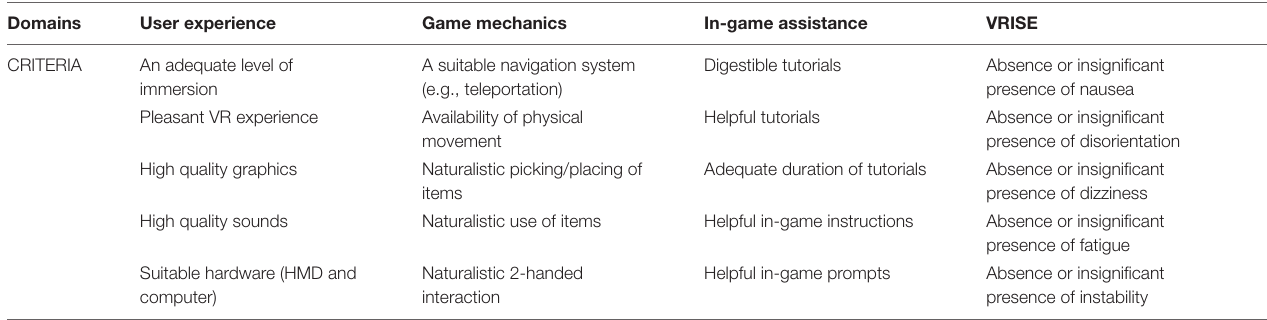
TABLE 1 | Domains and criteria for VR research/clinical